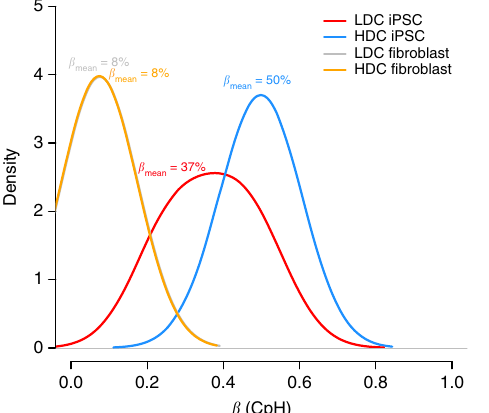
Figure 1 | Non-CG methylation is prevalent but reduced in LDC hiPSCs. Density plot illustrating the difference in non-CG methylation profiles between low-differentiation capacity (LDC; red line) and high- differentiation capacity (HDC; blue line) hiPSCs. The difference in mean methylation ( D b ) was large (13%) and significant ( P o 7.4 (cid:2) 10 (cid:3) 4 ). For comparison, non-CG profiles are plotted for donor cell lines giving rise to LDC (grey line) and HDC (orange line) hiPSCs; the difference between these donor cell lines was not